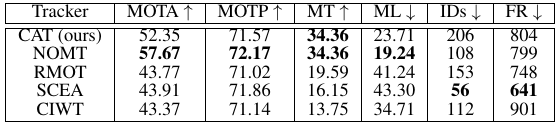
Figure 9. The histogram of 3D-MOTP w.r.t the distance between tracked pedestrians and the stereo rig. Tracker